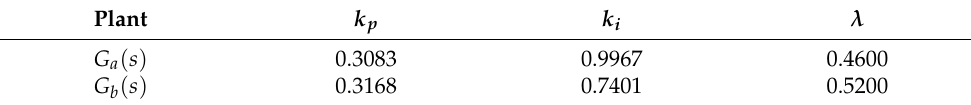
Table 4. FOPI controller parameters for φ m = 60 ◦ and ω gc = 5 rad/s.